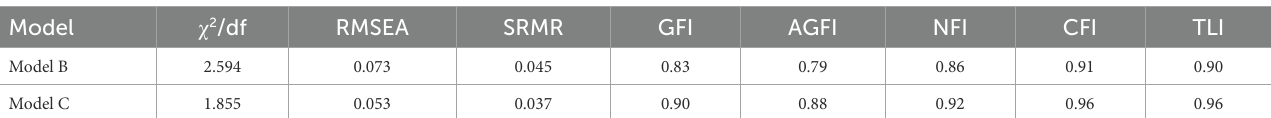
TABLE 3 Fitting index for confirmatory factor analysis of Model B &